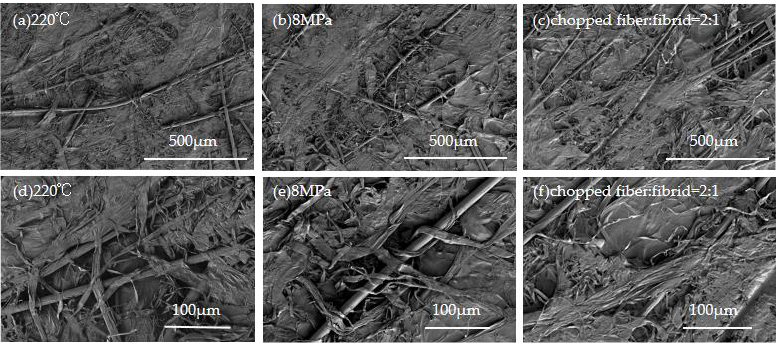
Figure 12. Micro-morphology of insulating paper when hot pressing temperature, pressure, and precipitating fiber content are low.